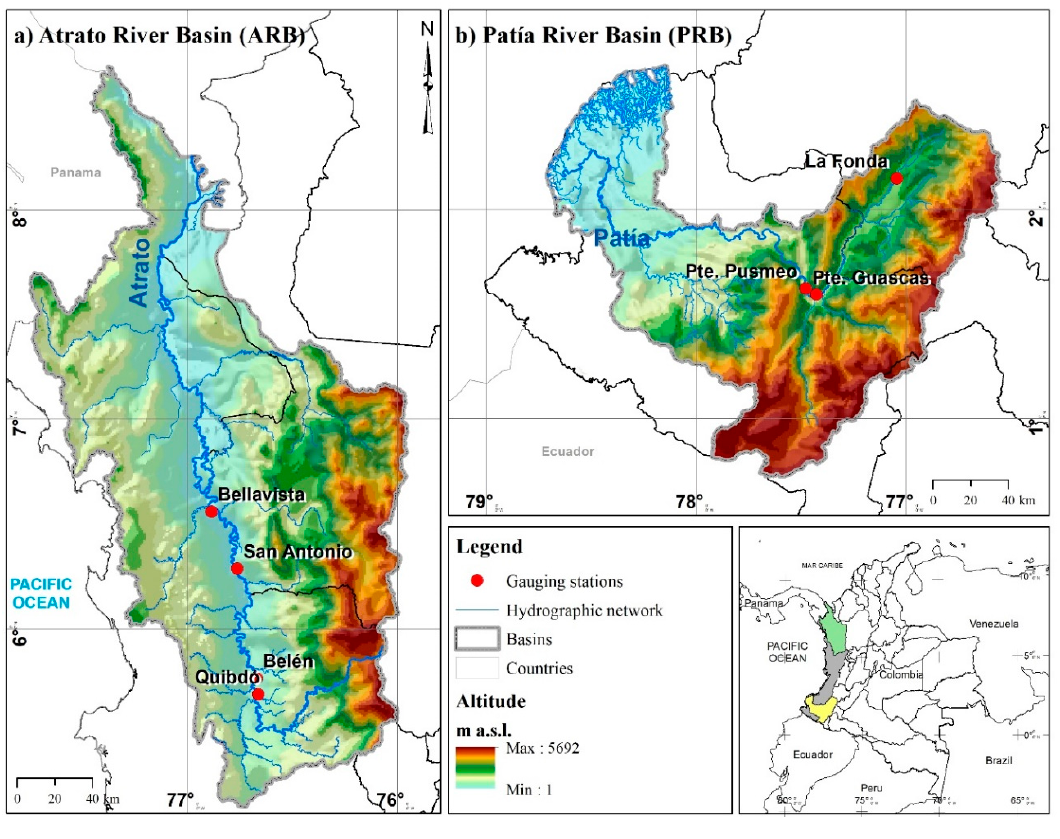
Figure 1. Geographic location of the Atrato and Patía River Basins in the Colombian Pacific region.